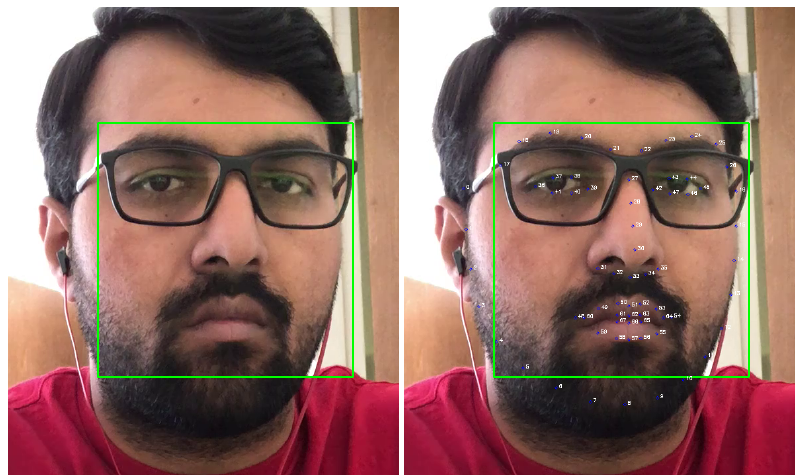
Figure 7. ( left ) Face detected by DLIB’s face detection algorithm. ( right ) Landmarks detected by DLIB’s landmark detection algorithm.